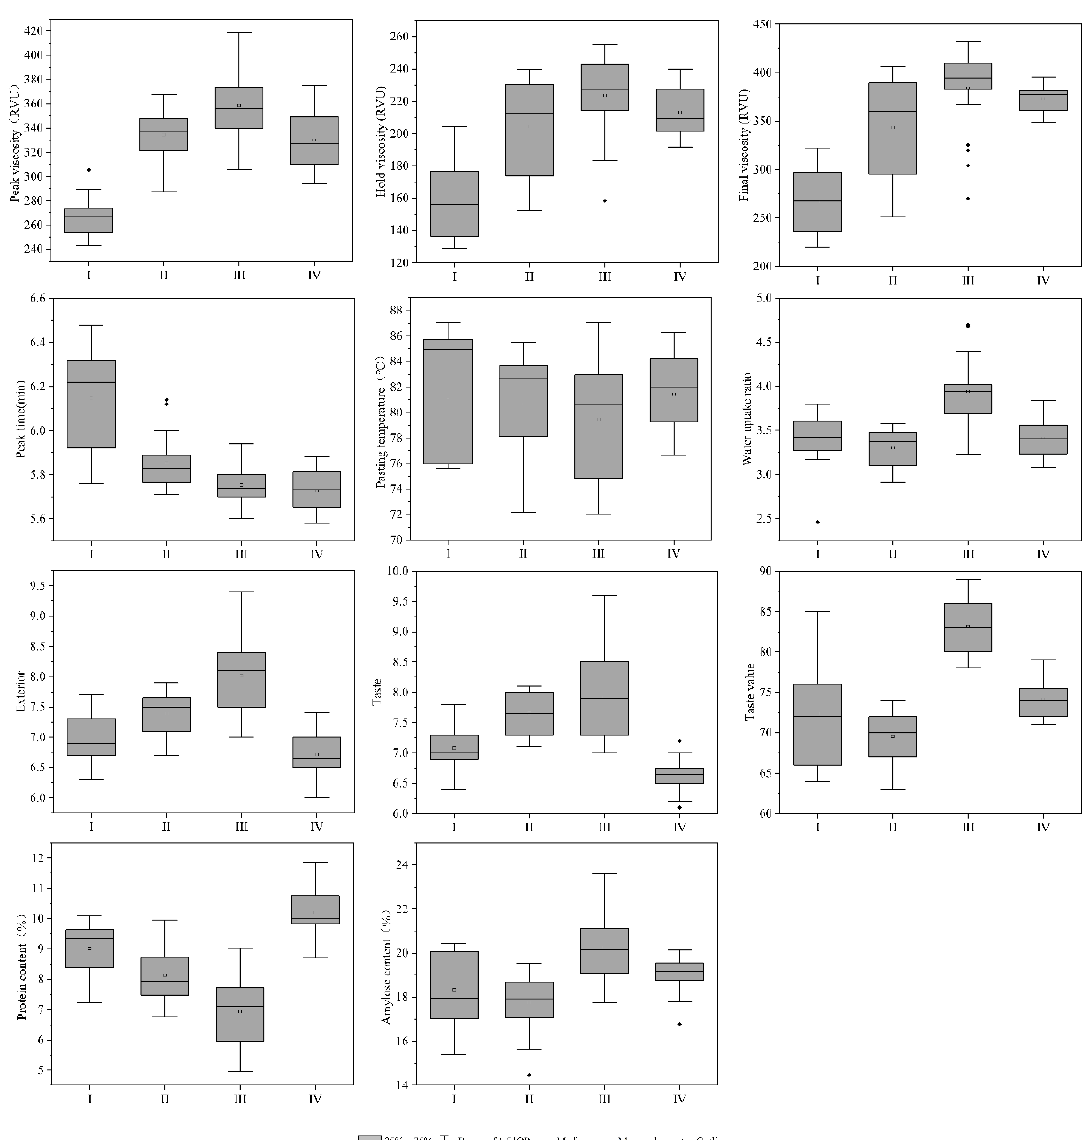
Figure 4. Cooking and eating quality of rice.